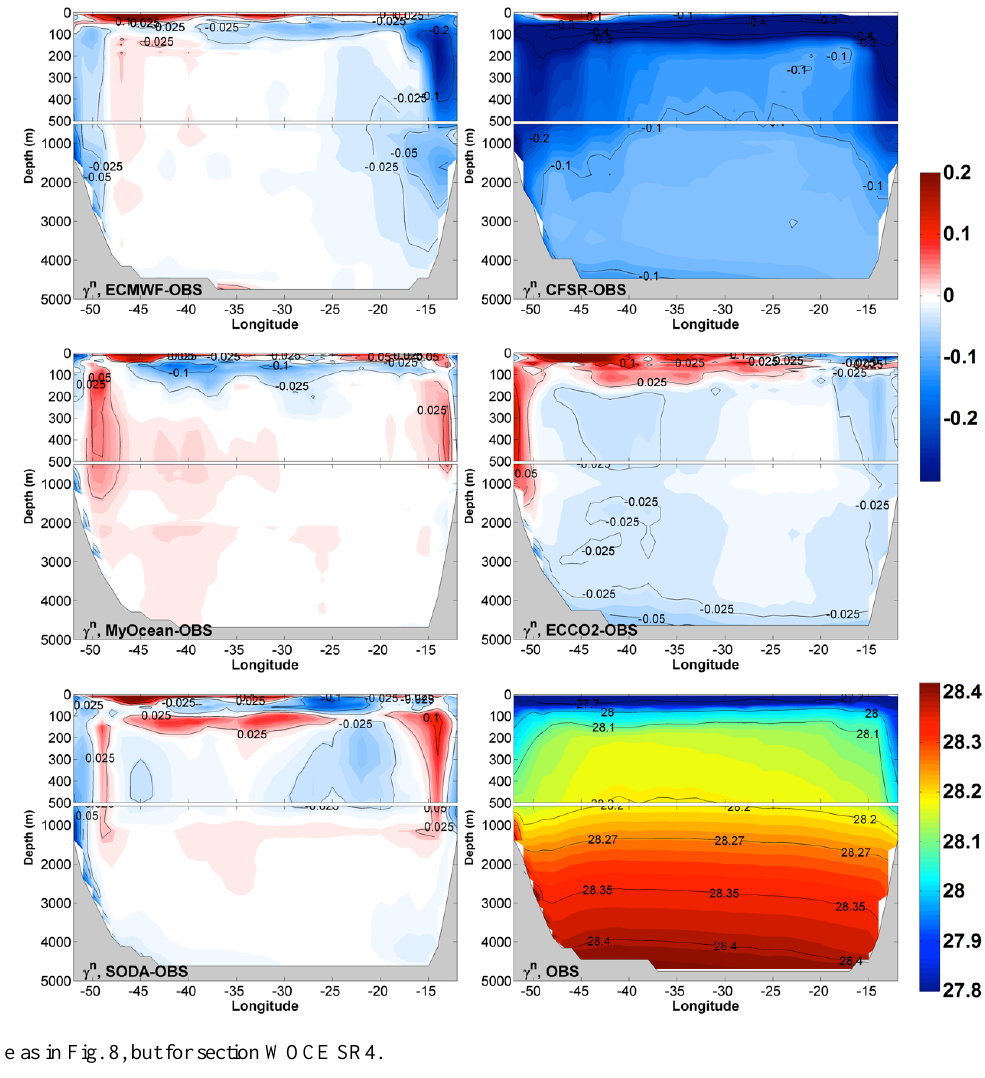
Figure 9. Same as in Fig. 8, but for section WOCE SR4.